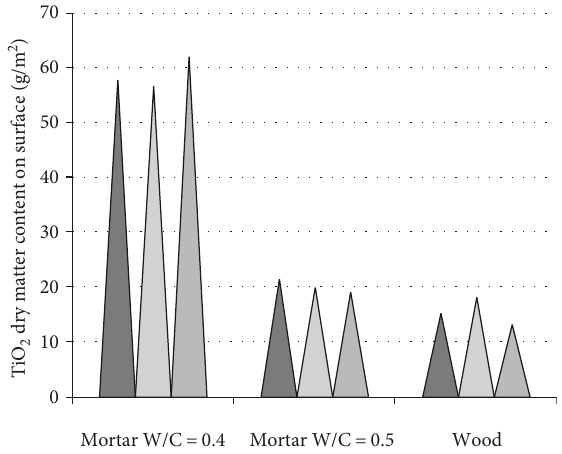
Figure 5: TiO dry matter content in g/m 2 obtained on the surface 2 for the three substrates tested when using the 12wt% TiO dispersion. The coating method was used for each substrate